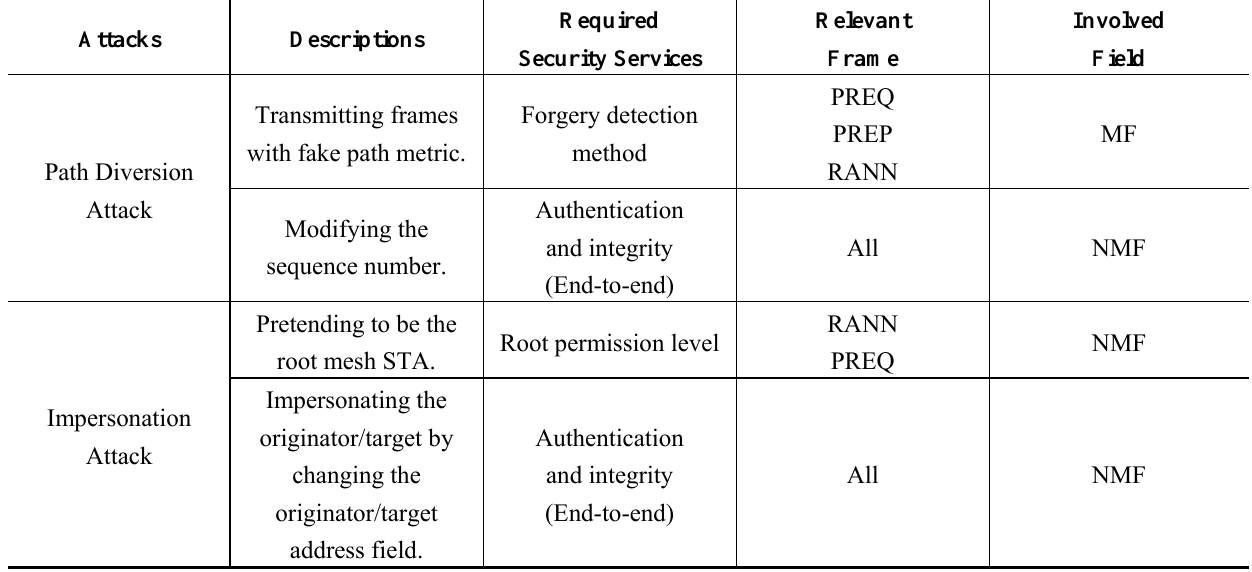
Table 8. Internal attacks, the required security services, and the relevant HWMP frames and fields involved.